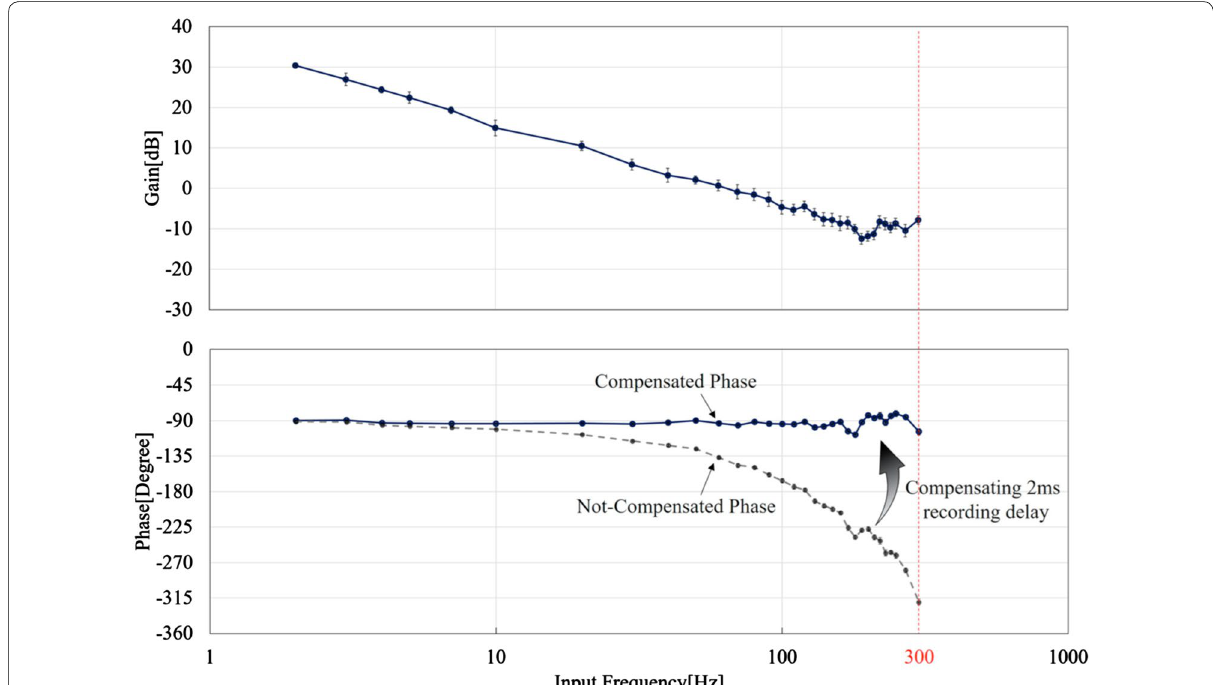
Fig. 5 Example of frequency characteristics of the on-chip cell manipulation system (The figure is taken from [54] (reproduced under CC BY-NC-SA 4.0, see the reference for